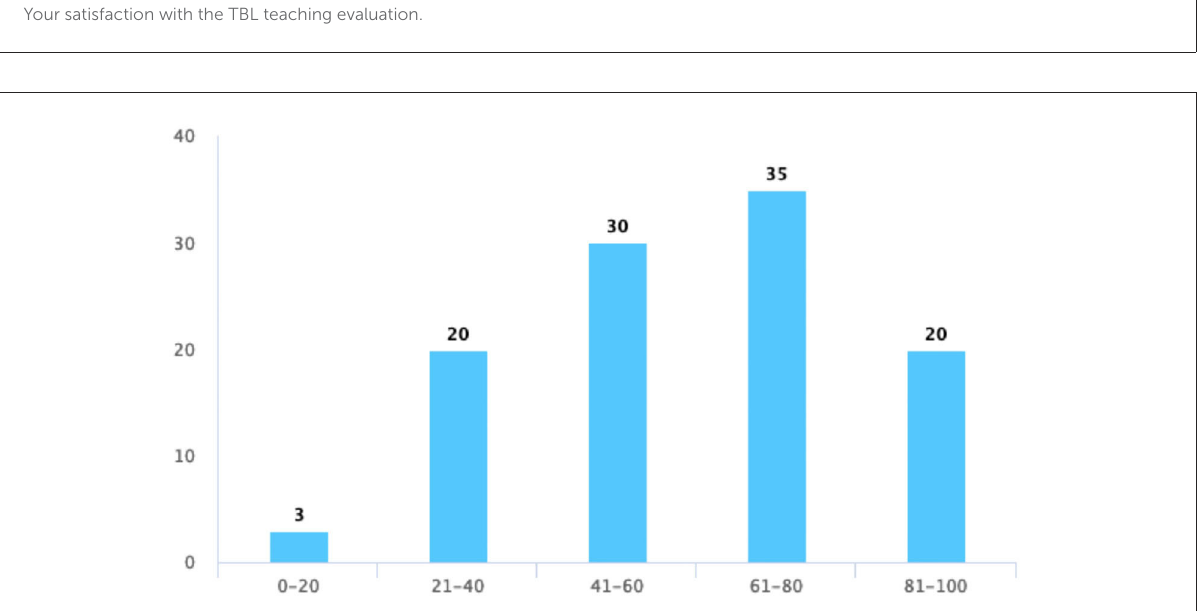
FIGURE5 Evaluation of an active atmosphere in the TBL